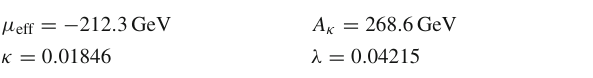
Table 2 Mass spectrum of our NMSSM point as given by NMSSMTools . In the Higgs sector we have the lightest scalar Higgs h 1 , the SM -like Higgs h 2 , the Heavy Higgs H 3 , as well as the CP -odd Higgses a and A and the charged Higgs H ± . The neutralino sector is labeled with ˜ χ 1 ... 5 , and the chargino masses are denoted as m ˜ χ ±